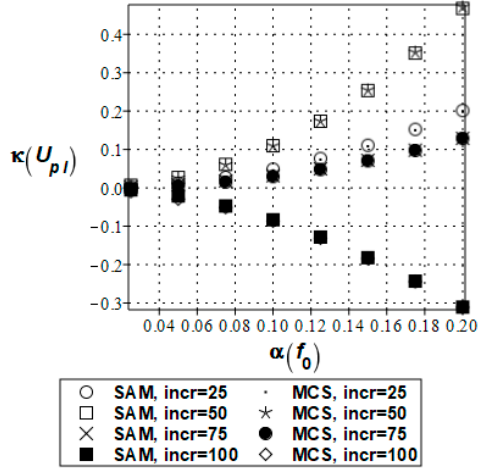
Energies 2020 , 13 , x FOR PEER REVIEW Figure 11. Kurtosis of elastic energy fluctuations. Figure 11. Kurtosis of elastic energy fluctuations.